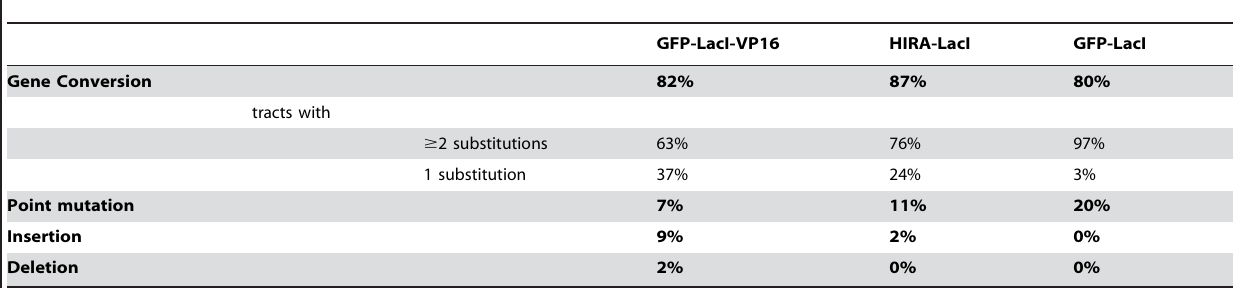
Table 1. Effect of Tethered HIRA and VP16 on Gene